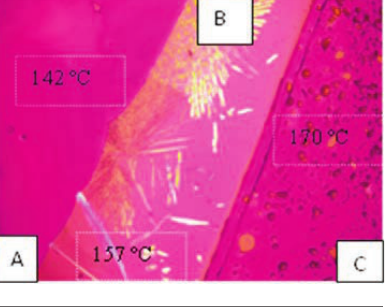
Figure 1. HSM photomicrograph (A) AS area Melting Point (MP) 142